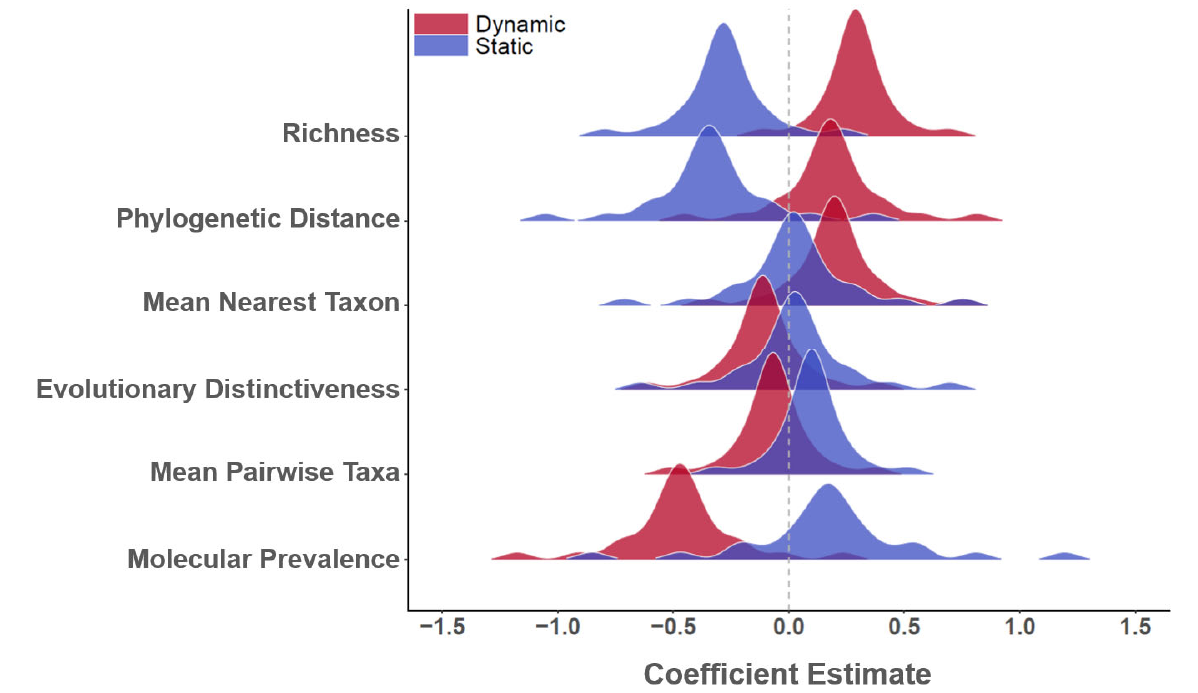
Figure 5. Avian host community composition, phylodiversity, and WNV prevalence posterior distributions. Vertical axis at left lists covariate names and horizontal axis provides numeric range of coefficient estimates. Distributions are color coded to indicate if the estimate corresponds to a dynamic (monthly varying) or static (season-based, May–August) avian species pool. Dashed vertical line intersects zero on horizontal axis to judge credible intervals and covariate polarity. The static implementations of mean nearest taxon distance, evolutionary distinctiveness, and molecular prevalence were determined not to be statistically significant based on 95% credible intervals. Neither the static or dynamic versions of mean nearest taxa distance were significant. All other other covariates were important indicators of WND